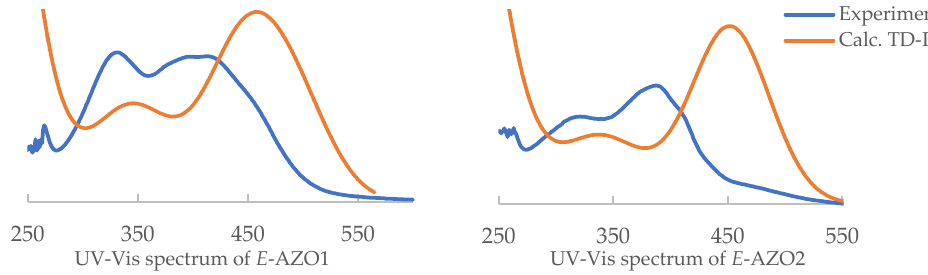
Figure 3. Measured and calculated absorption spectra of E -AZO1 ( left ) and E -AZO2 ( right ) in dimethylformamide.